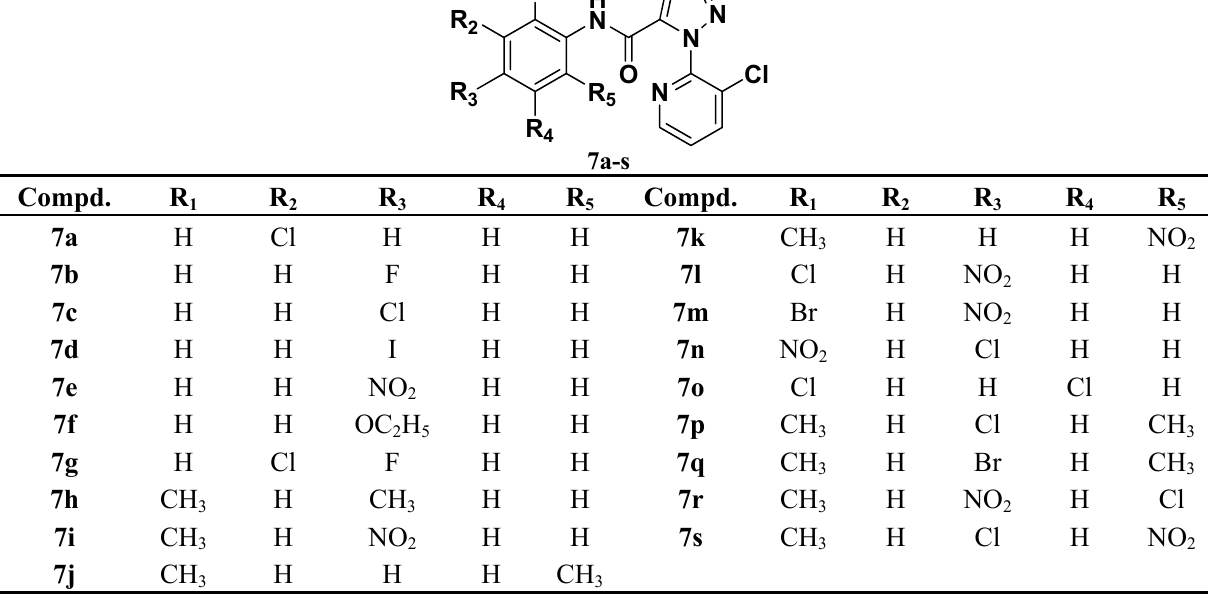
Table 1. List of N -pyridylpyrazole-containing amides 7a – s